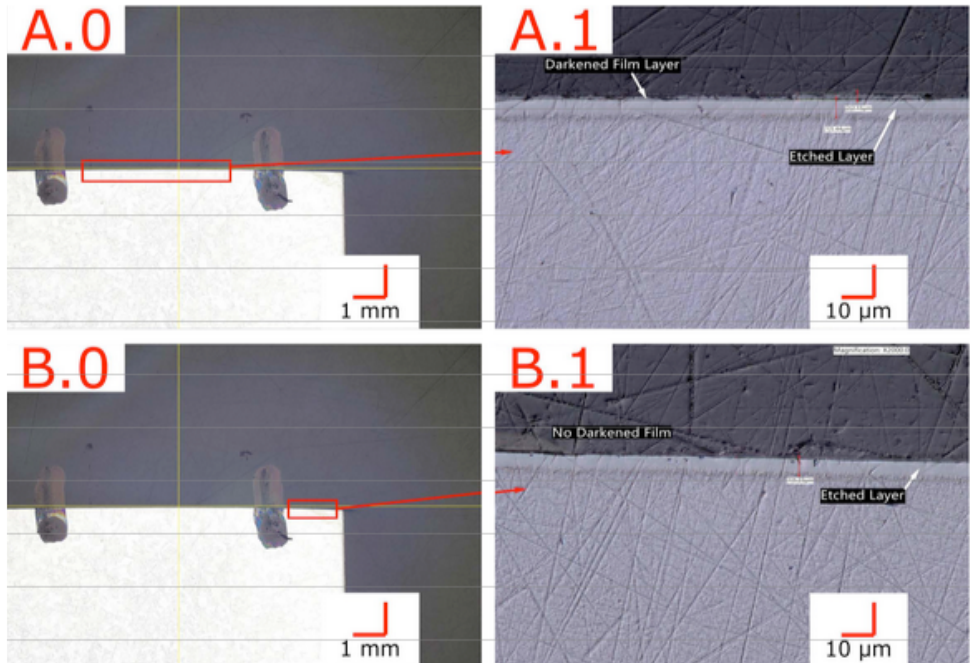
Figure 3. Cross-section of LTNC-SRP-treated wrought Alloy 22 with an apparent infused-zone depth ζ LOM ≈ 6 µ m. ( A.0 , A.1 ) Region exhibiting a ≈ 2 µ m thick dark film. ( B.0 , B.1 ) Region without dark